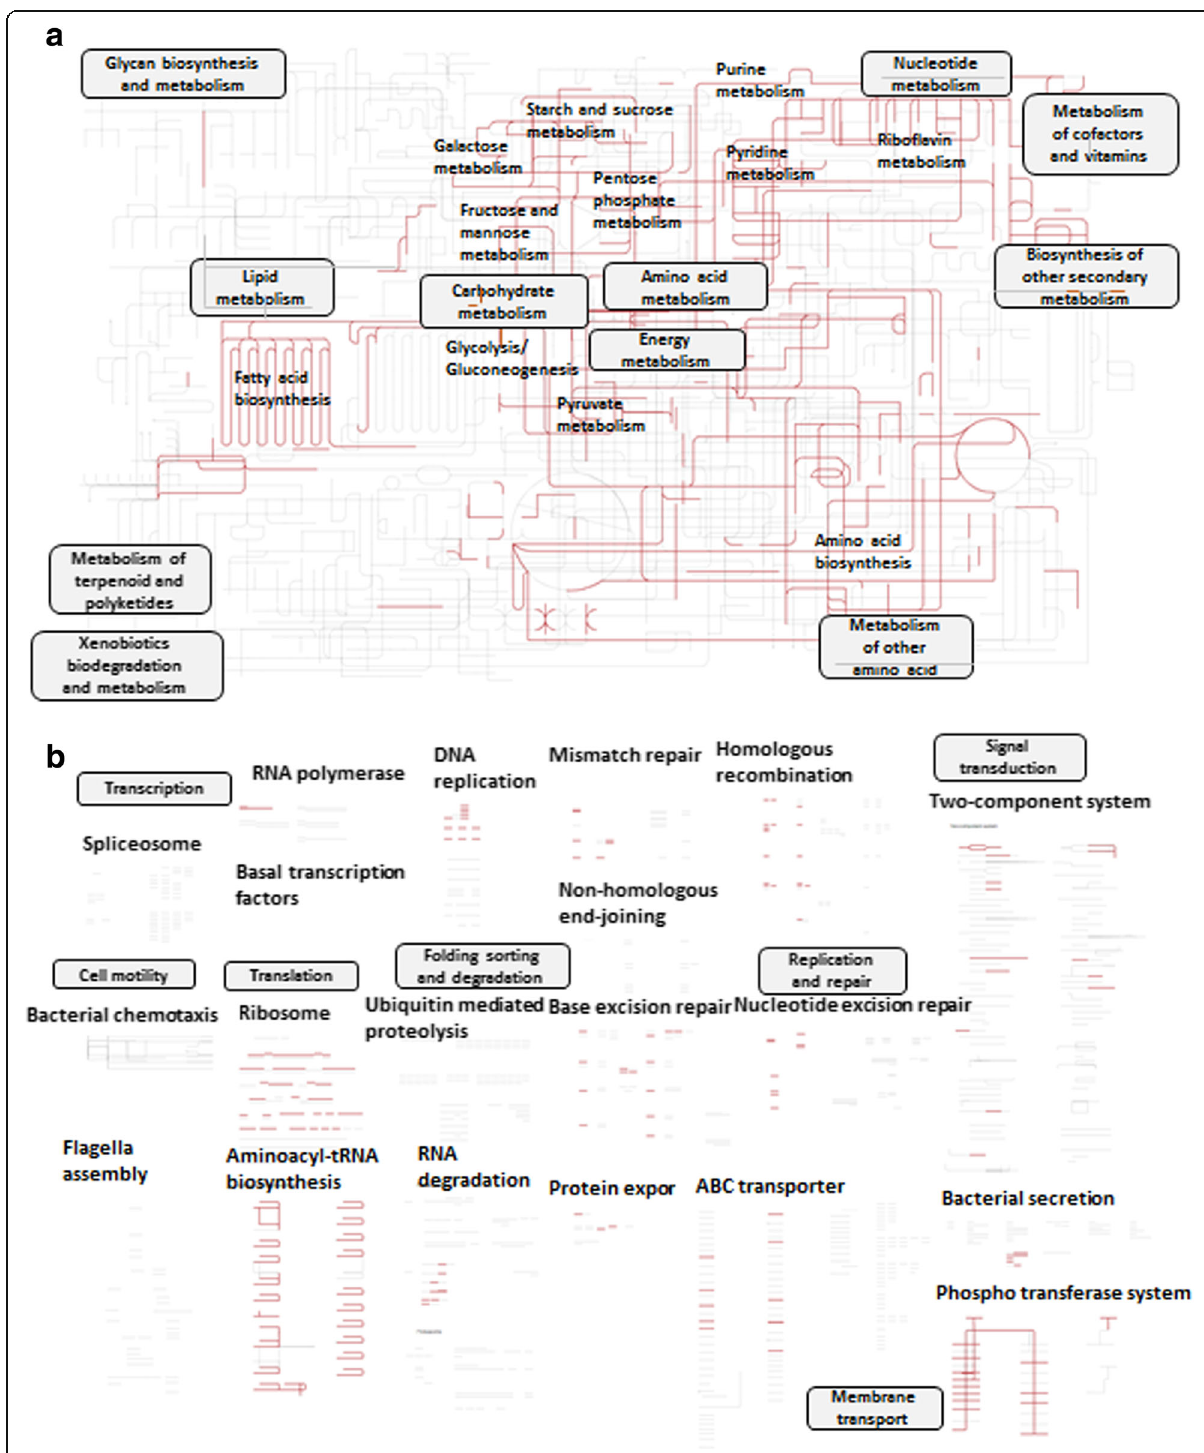
Fig. 4 KEGG metabolic ( a ) and regulatory ( b ) pathways of Leuconostoc suionicum DSM 20241 T . The pathways were generated using the iPath v2 module based on KEGG Orthology numbers of genes identified from the genome of L. suionicum DSM 20241